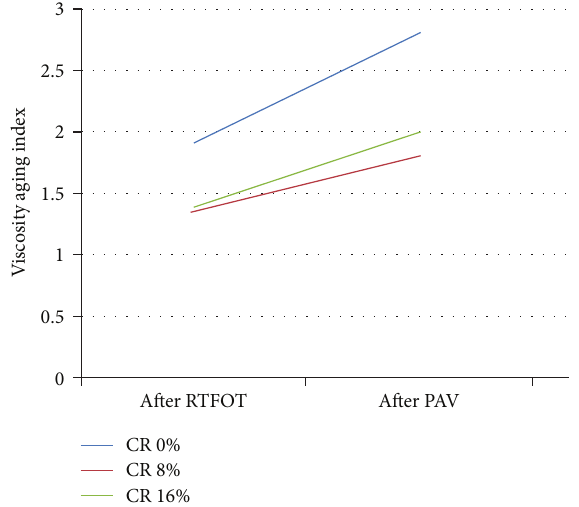
Figure 3: VAI of original and rubberised modified bitumen after RTFOT and